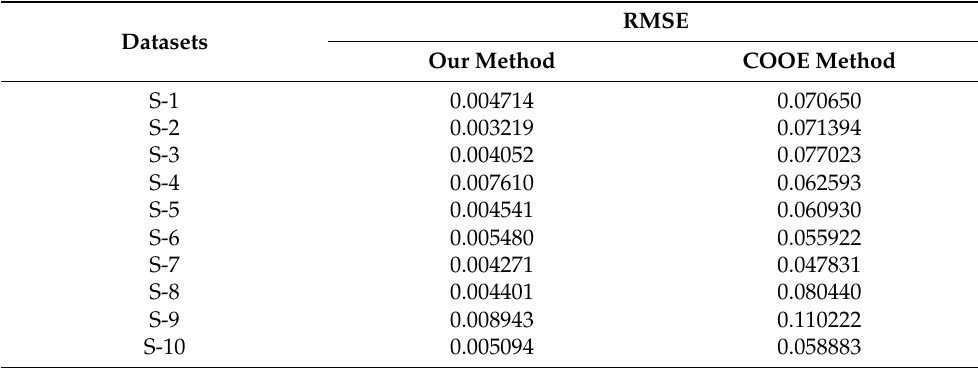
Figure 7. The comparison of detection results in the semi-real data segment. Based on the detection results above, we compare the OBE interference repair perfor- mance of the proposed method with that of the interpolation method in COOE on the same datasets. The comparisons of the repair results are shown in Table 4. Table 4. Comparisons of repair results between the proposed method and the COOE method in semi-real